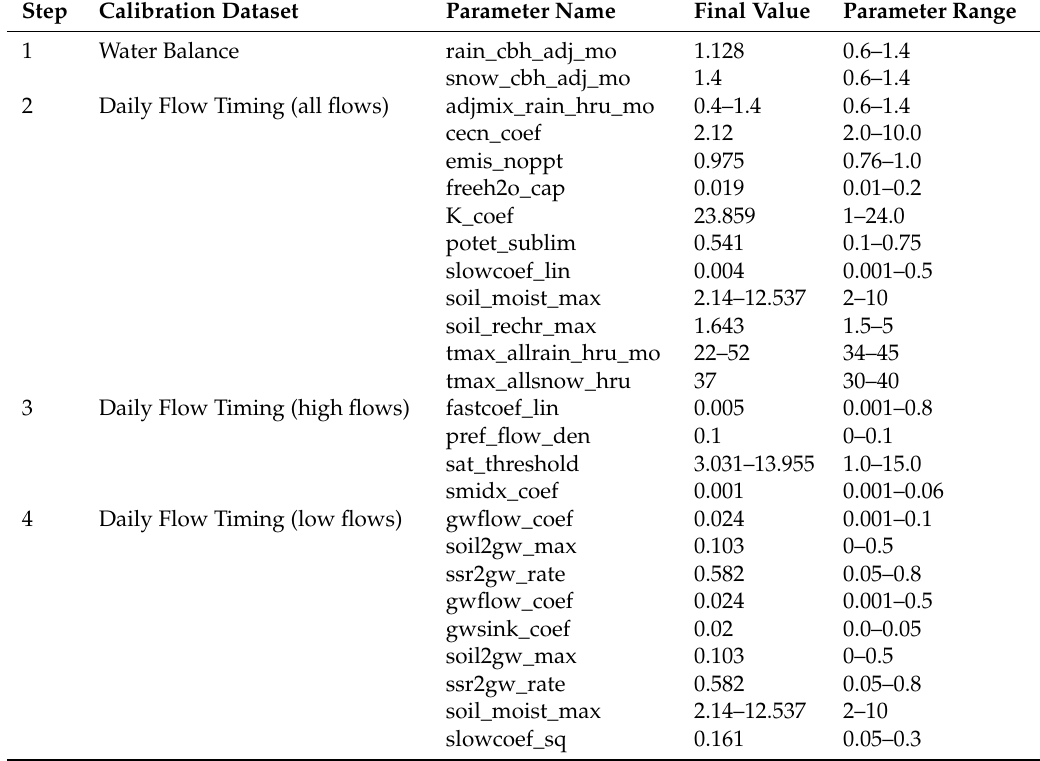
Table A3. Final model parameters used after